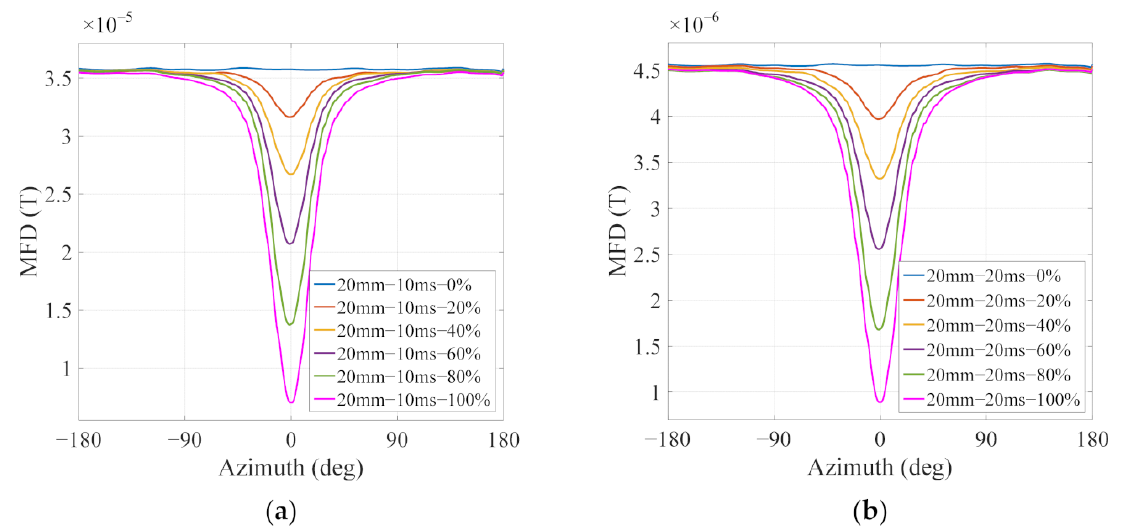
Figure 7. Azimuth dimension curves of 20-mm hole defects with different PDs at sampling times: ( a ) 10 ms and ( b ) 20